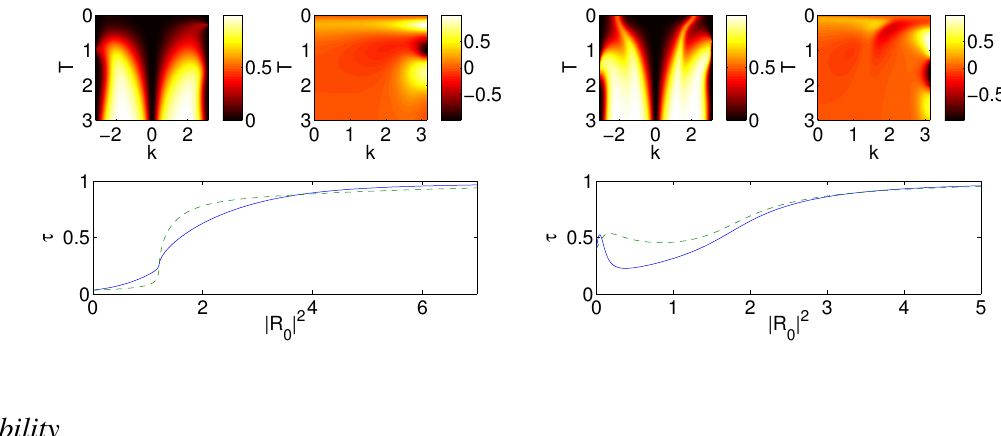
Figure 1. Each panel contains a contour plot of the transmission coefficient τ ( k, T ) ( top left ) and a contour plot of the rectification factor f ( k, T ) of Equation (9) ( top right ), plotted as a function of k and T . The panels also show a typical example of the dependence of τ for k = 2 (solid lines) and k = − 2 (dashed lines), so as to illustrate the asymmetry between the propagation for left and right incident waves ( bottom panel). In the latter the dependence of τ is given as a function of | R | 2 . The left panel corresponds to N = 2 and γ 0 and the lattice size is L = 200 in this case. The right panel is the N = 3 case with γ γ = 2 and γ = 3 . 5 ; here the lattice size is L = 201 2 3